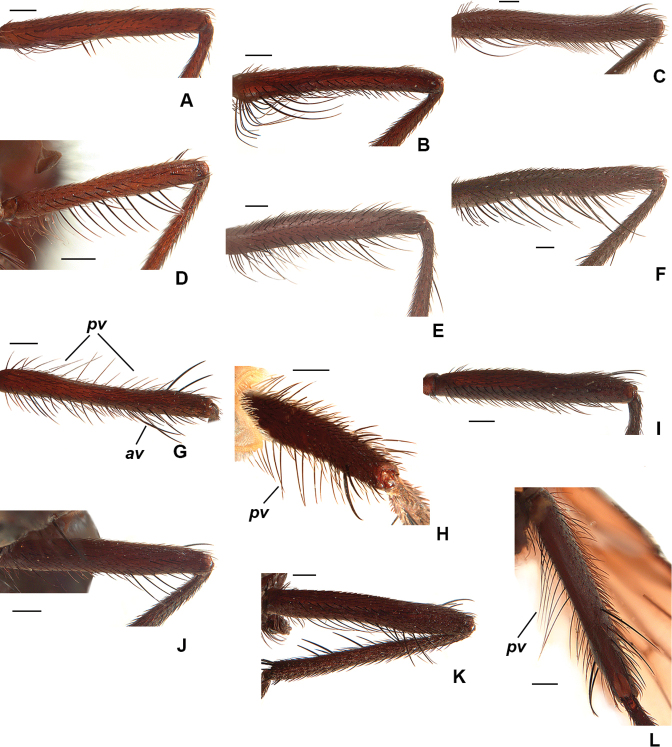
Male mid femur, anterior view (except G, H, L) AD.
cantabrigensisBD.
setibasisCD.
vockerothiDD.
profrontalisED.
glacialisFD.
quadrisetosaGD.
santamonicae, antero-dorsal view HD.
amnicola, postero-dorsal view ID.
similisJD.
amnicolaKD.
huckettiLD.
aldrichi, ventral view. Scale bars: 0.25 mm.